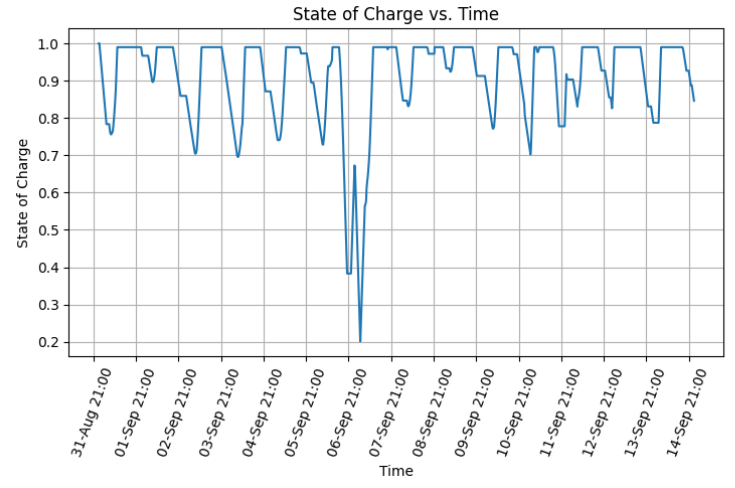
Figure 16. State of charge for a microgrid with 60 kW diesel generation capacity, 81 kW photovoltaic power rating and 360 kW h BESS. · ·